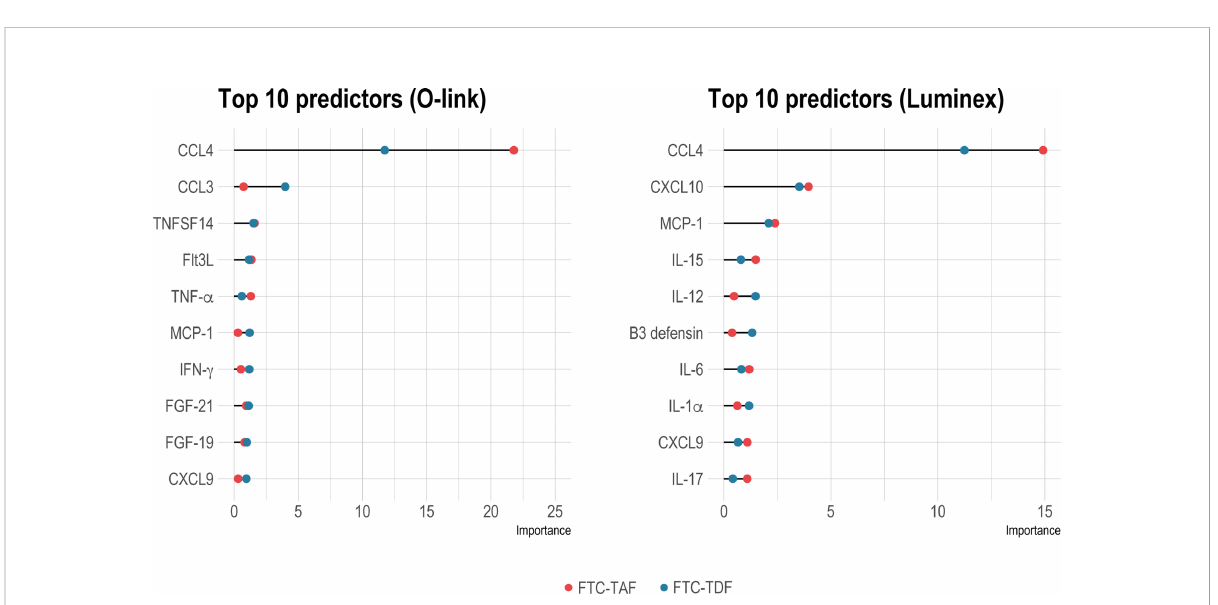
FIGURE 3 Identi fi cation of group status predictors by random forest analysis. Random forest analysis to reveal important predictors between pre- and post-PrEP groups in individuals receiving either FTC-TDF (blue dots) or FTC-TAF (red dots) is shown in on the left for Olink and on the right panel for Luminex. The top-ten signi fi cant predictors (p < 0.01) are shown.